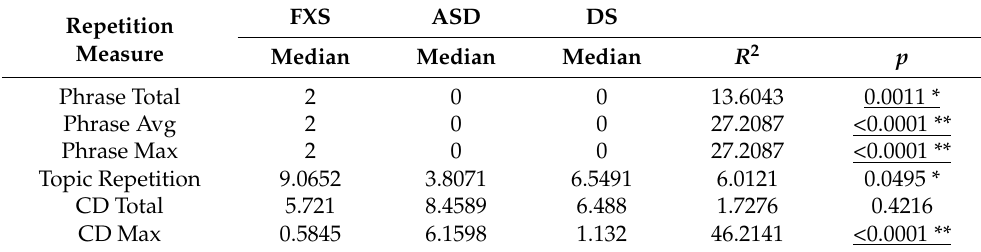
Table 3. Median regressions for repetition measures after controlling for number of